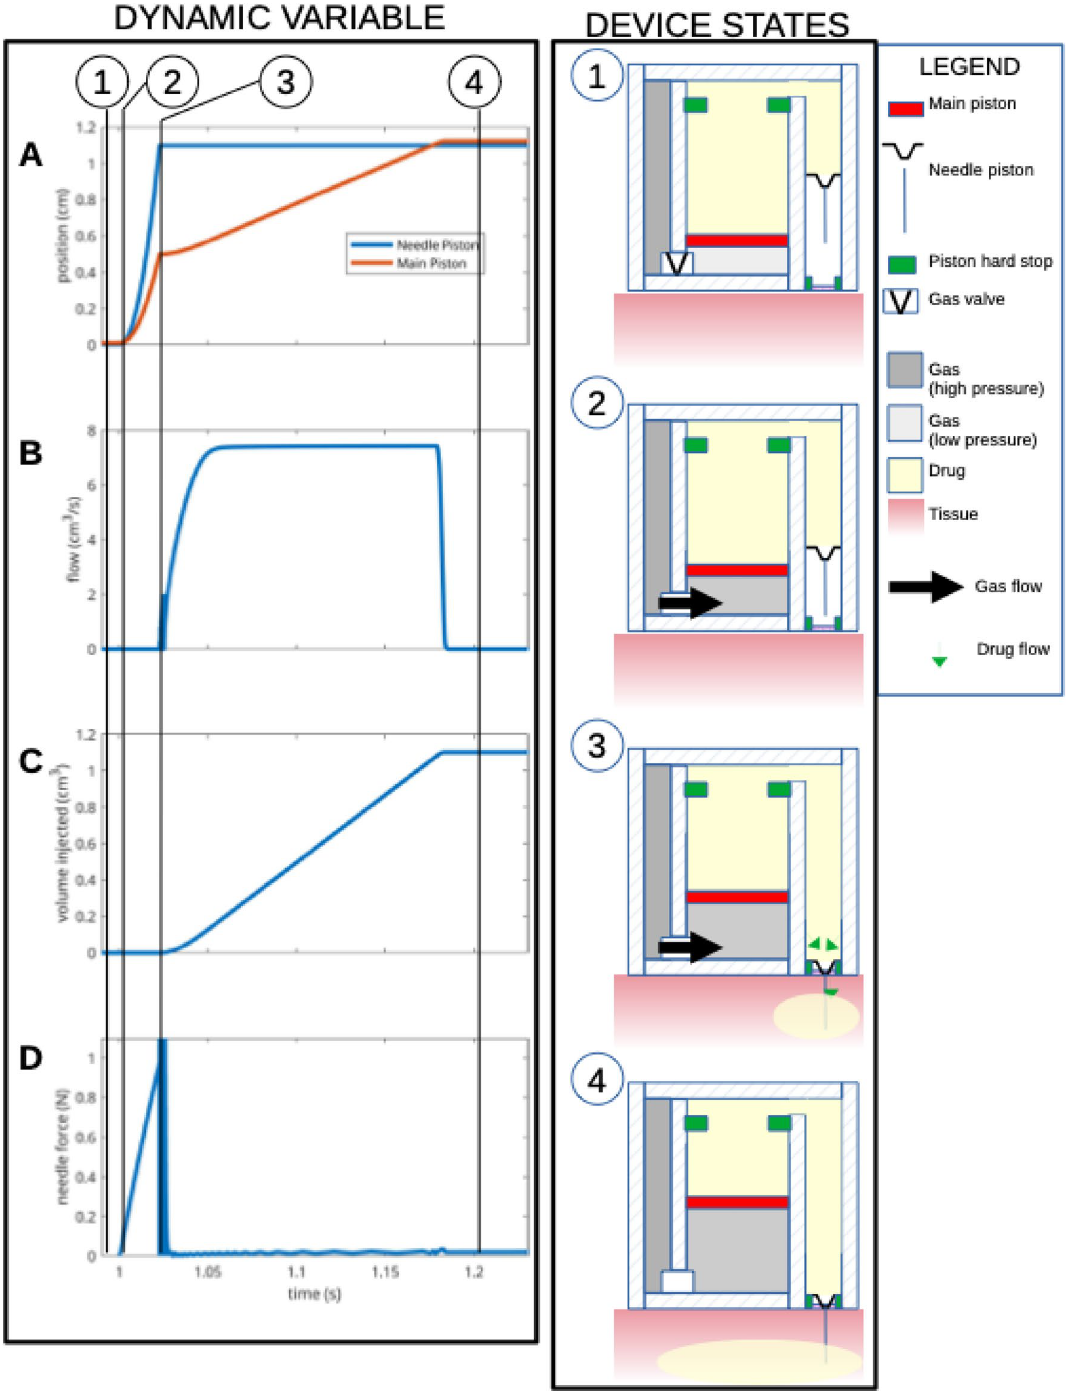
Figure 3. Dynamic model simulation of the mechanical pump system shown for the initial injection cycle. Left panels show time evolution of dynamic variables: ( A ) position of main piston (red trace) and needle piston (blue trace), ( B ) flow of drug through the needle, ( C ) volume of drug injected into the subcutaneous tissue, ( D ) force applied on the needles. Right panels: State of the device at various time points. Balloons 1–4 mark time points which correlate with dynamic states of the device as shown in the left panels 1–4. Shown is a replica of the device mechanics for the initial cycle of engagement following triggering when an SpO2 of less than, or equal to 90% has been sensed by the oximeter. See text for further